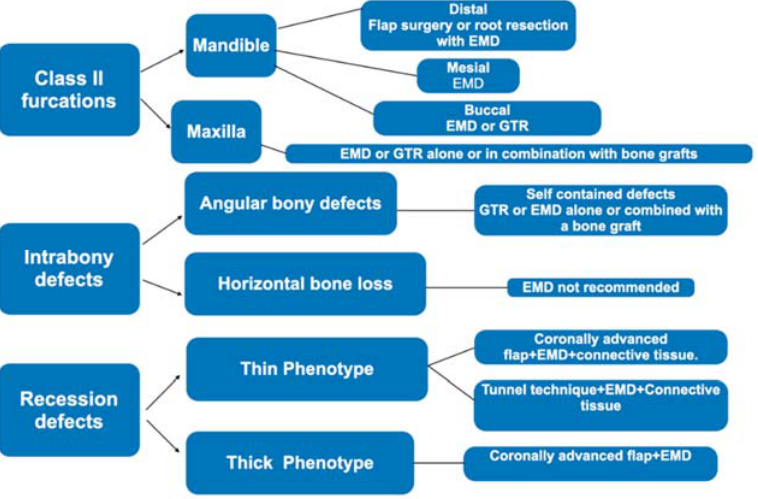
Figure 7. Clinical indications for EMD in periodontal regeneration with respect to the defect’s type modified from Miron et al. [95].